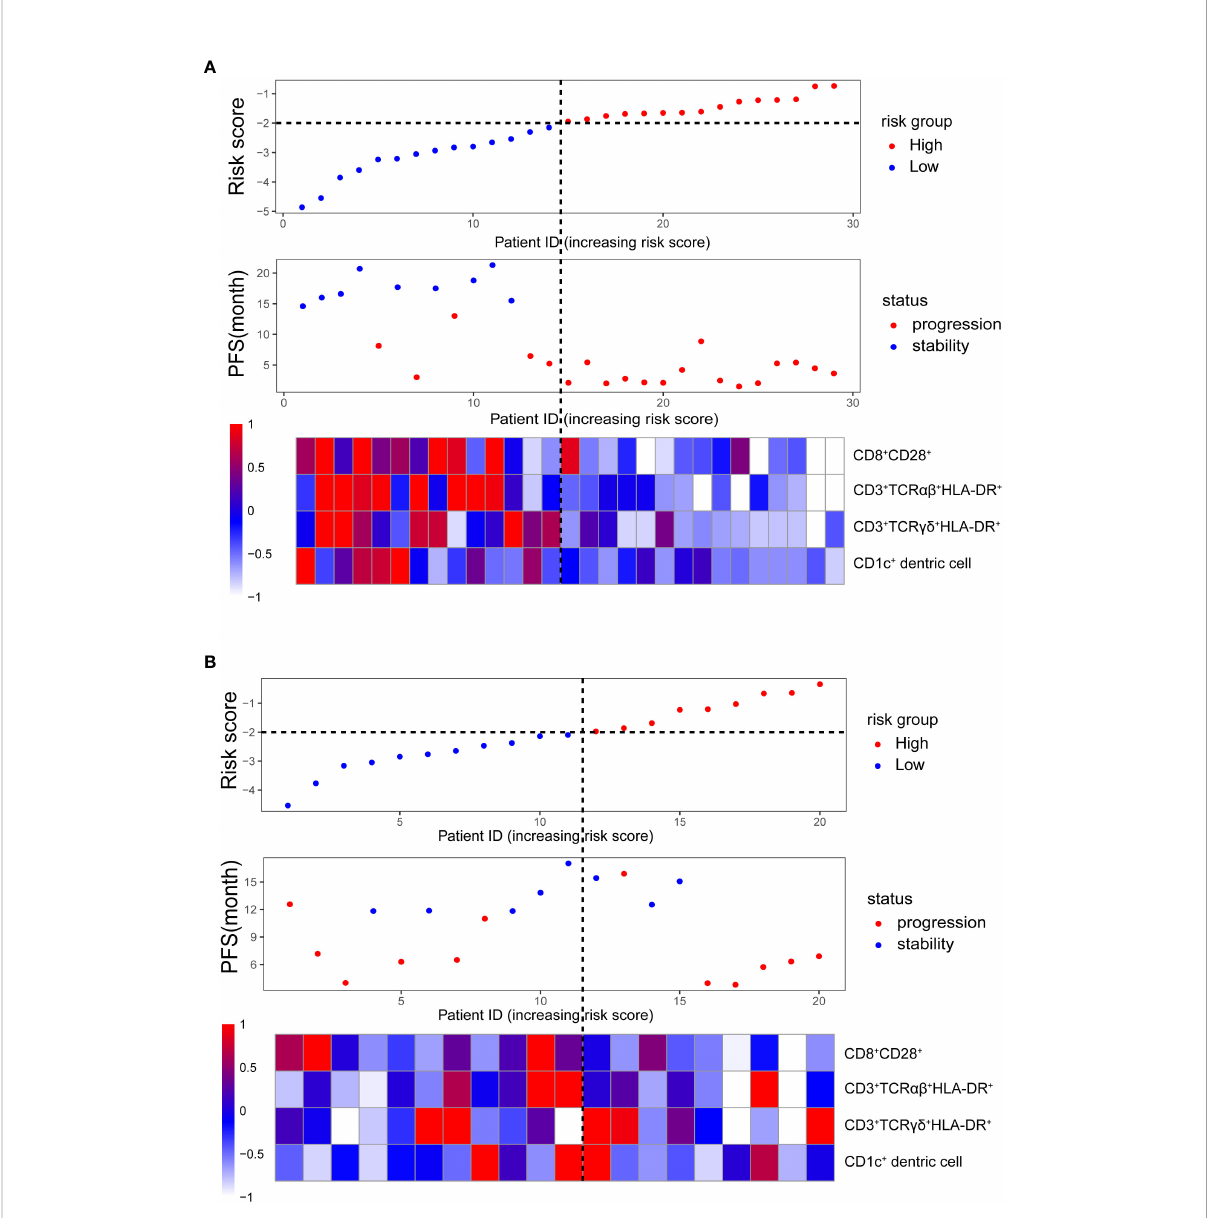
FIGURE 2 Clinical characteristics of malignant melanoma patients (in order from top to bottom): the risk score distribution in high- and low-risk groups; the progression-free survival status distribution increasing the risk score; the heatmap of the absolute counts of four-immune cell-subset pro fi les, representing the median value expressed by markers normalized to the range of 0 to 1. (A) Training cohort. (B) Validation